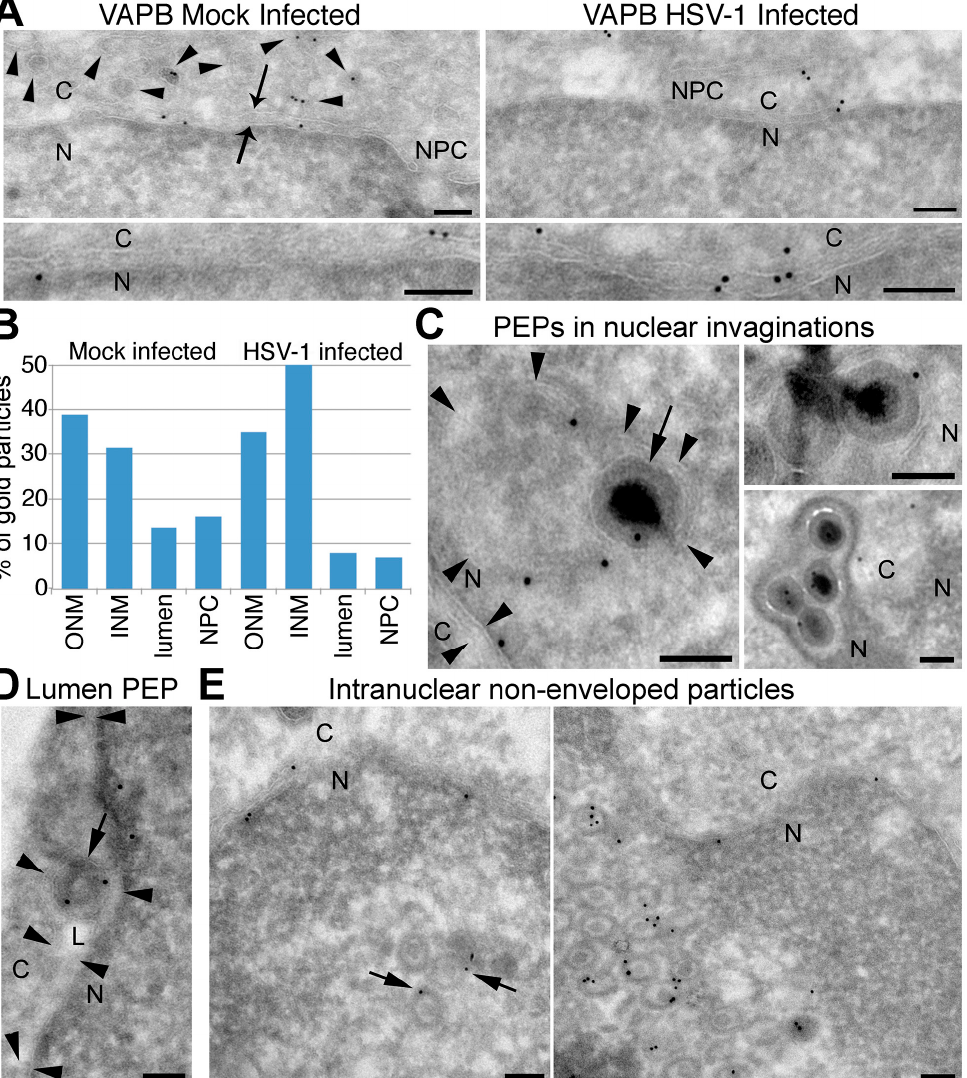
Figure 8. VAPB accumulates in both the ONM and INM and associates with virus particles. HeLa cells, either mock infected or infected with WT HSV-1 MOI = 10, were fixed at 16 hpi and cryosectioned prior to labelling with VAPB mouse monoclonal antibodies and anti-mouse conjugated gold particles for electron microscopy. ( A ) Mock infected cells (left panels) and HSV-infected cells in areas lacking virus particles (right panels) to investigate the membrane localizations of VAPB. In all panels, the cytoplasm is on the top and the nucleoplasm is on the bottom with this labeled in the upper left panel by C and N, respectively, and nuclear pore complexes in the top panels are labelled NPC. The upper left panel also contains two arrows that face towards the ONM and INM. A subset of visible ER membranes, many in association with gold particles, are indicated with arrowheads. ( B ) Quantification of 206 and 163 VAPB-labelled gold particles at the NE from respectively the mock infected and HSV-1 infected populations using 81 images each. The percentage of total NE gold particles associated with different parts of the nuclear membrane are plotted. Notably, a reasonable number of VAPB ‐ labelled gold particles were observed in all membrane compartments: ONM, INM,